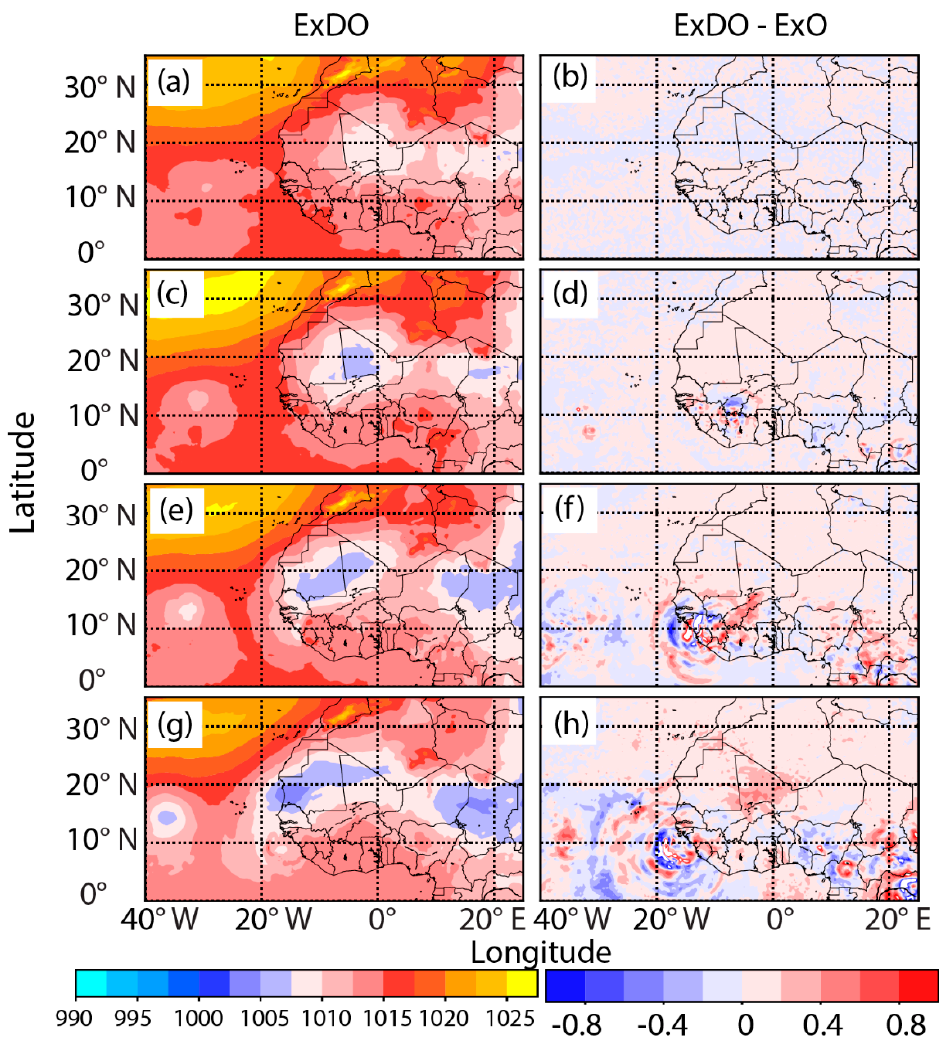
Figure 6. Sea level pressure (hPa) from ExDO (left column) and the differences (ExDO − ExO) (right column) at ( a , b ) 1300 UTC 21, ( c , d ) 0000 UTC 22, ( e , f ) 1200UTC 22, and ( g , h ) 0000UTC 23 August 2011.